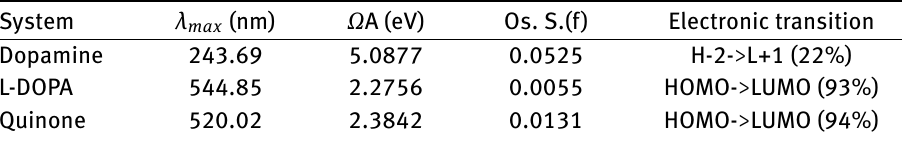
Table 2: The values of wavelength of maximum emission ( λ max ), vertical excited of energy ( Ω A), oscillator strength (f), and major electronic transition of the dopamine , L-DOPA, and quinone with TD-DFT